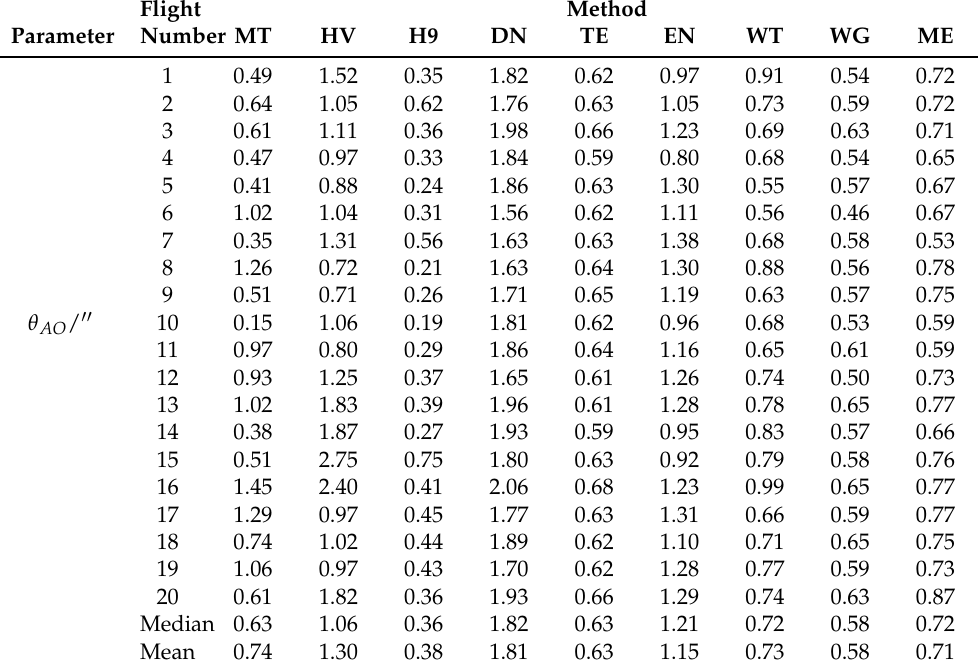
Table A9. NCACN integrated astronomical parameters details ( θ AO @ λ = 550